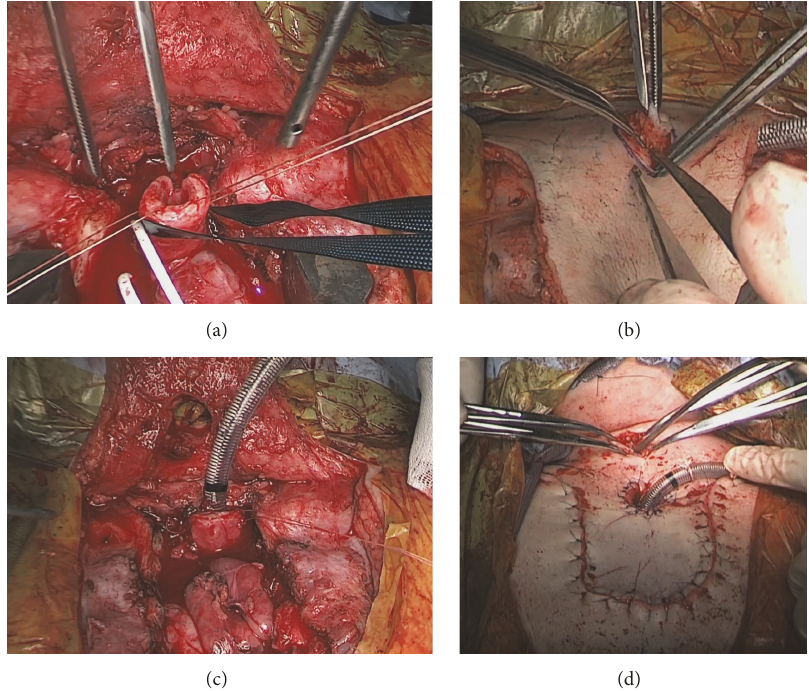
Figure 3: Intraoperative view of the mediastinal tracheostoma. (a) View of the tracheal lumen after tracheal resection. (b) An electric scalpel was not used to create the tracheostoma. (c) View from the back of the U-shaped flap after creation of the tracheostoma. (d) After skin closure following construction of the mediastinal tracheostoma.